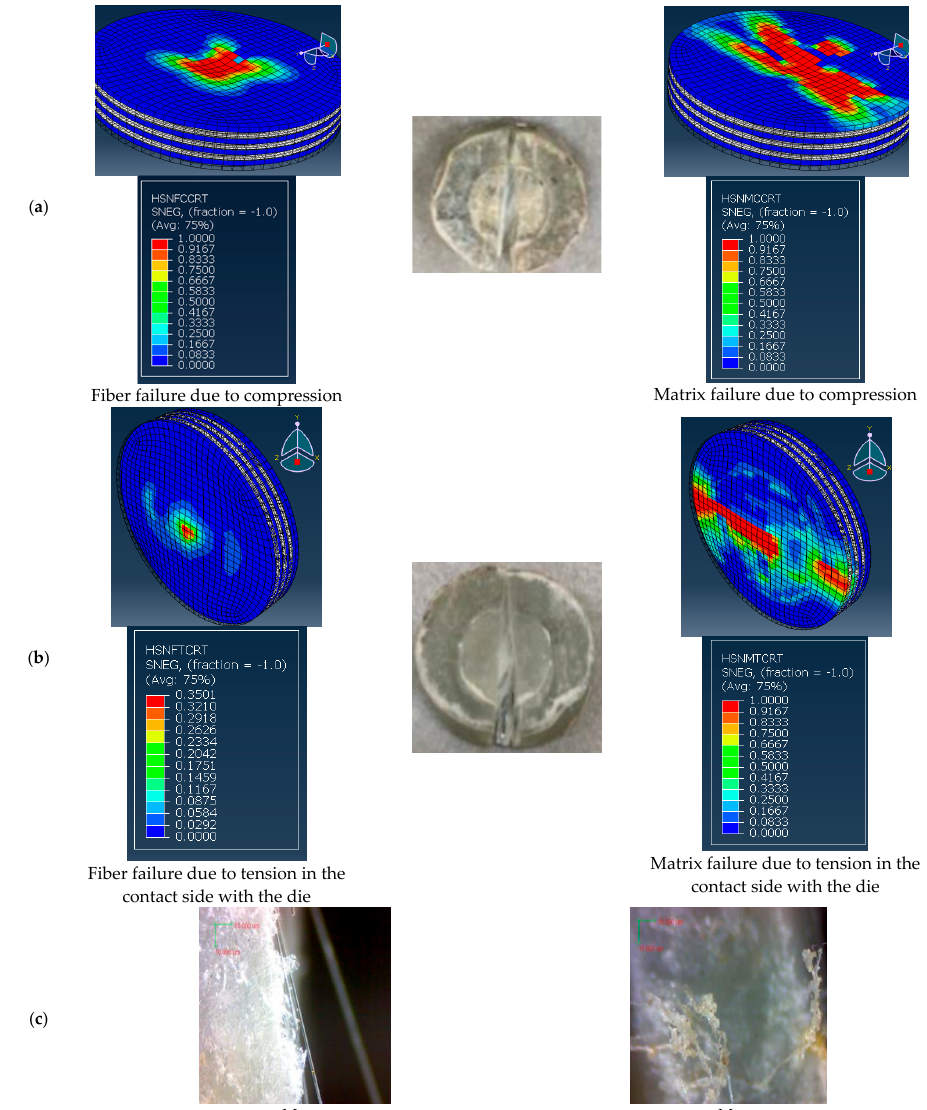
Figure 16. Failure of experimental and numerical of conventional specimens. ( a ) Layer opposite punch ( M 6 ), ( b ) Layer opposite punch ( M 6 ), ( c ) Scan of the specimen.